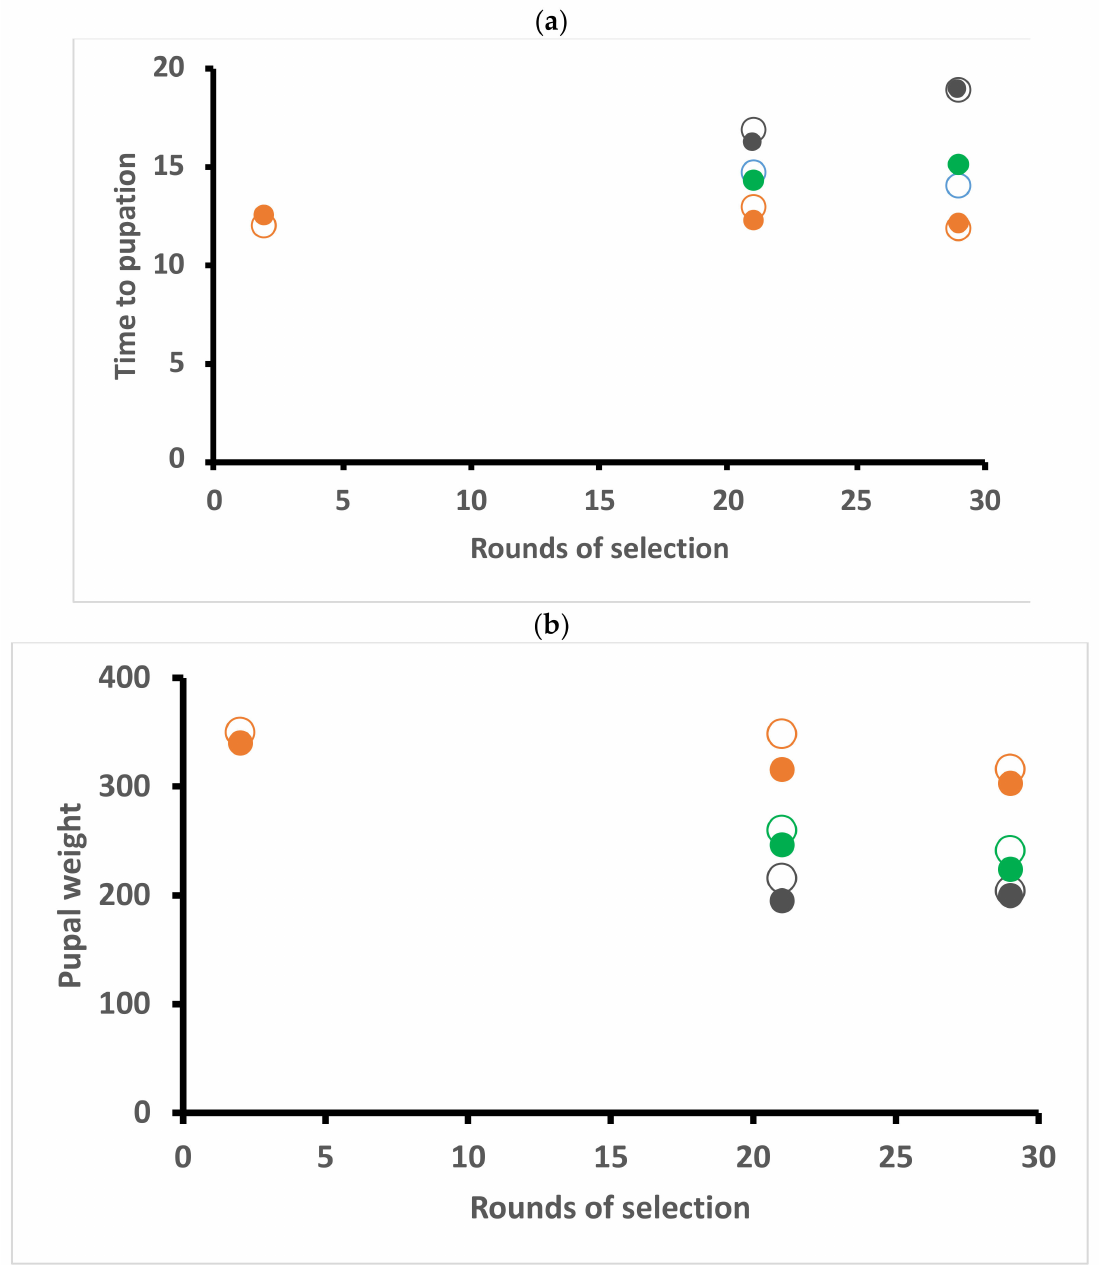
Figure 3. Time to pupation in days ( a ) and pupal weight in mg ( b ) of Helicoverpa armigera Toowoomba strain (large open circles) and Brassica-selected strain (solid smaller circles) when reared on artificial diet (brown), cabbage (dark green) or kale (light green) assessed at the indicated rounds of selection. Performance on artificial diet is plotted for the second selection round but were not used in the analysis (Supplementary Table